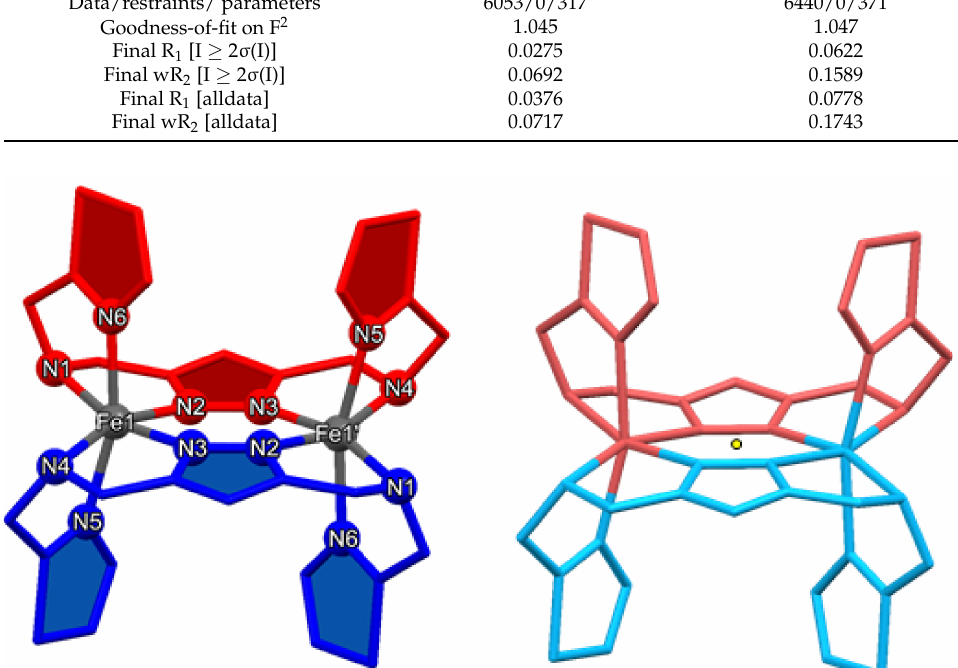
Figure 1. ( Left ): Labeling scheme for [Fe 2 (- L Thiazole ) 2 ] 4+ complex cations. Cis-axial coordination mode of the ligands is displayed by the colors red and blue. ( Right ): Symmetry equivalent moieties in all [Fe 2 (- L Thiazole ) 2 ] 4+ complex cations due to an intrinsic inversion center (yellow dot). The color scheme was adapted to the symmetry-equivalent